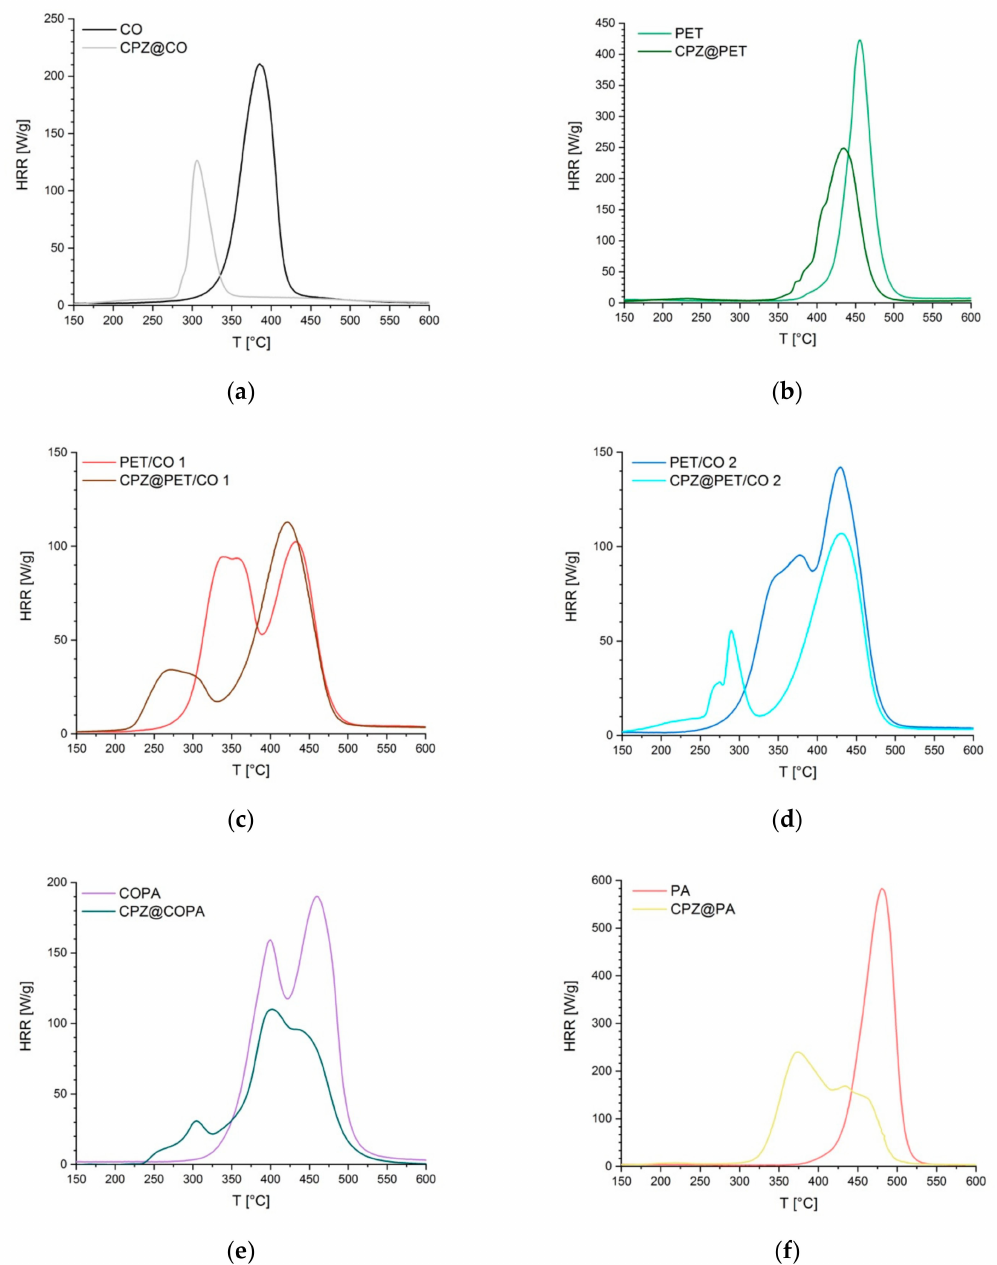
Figure 5. Microscale combustion calorimetry (MCC) of native and CPZ finished textiles, ( a ) CO; ( b ) PET; ( c ) PET / CO 1; ( d ) PET / CO 2; ( e ) COPA, and ( f ) PA 6.6 measured following ASTM D 7309 Method A. The add-on value for all samples is around 10